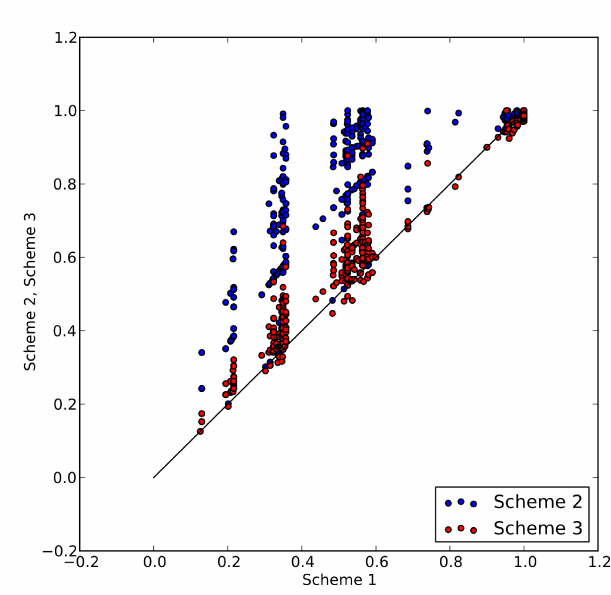
Figure 1. Scatter plot: scheme #1 vs schemes #2 and #3